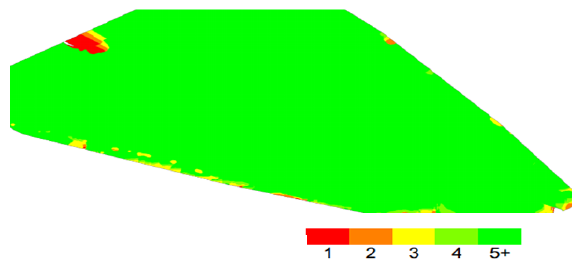
Figure 8. Number of Overlapping Images